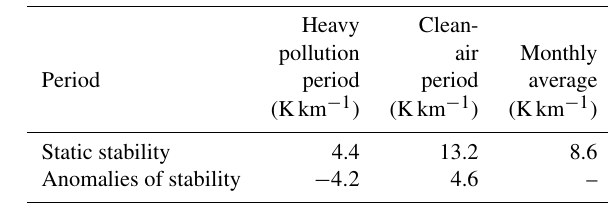
Table 3. Atmospheric static stability below heights of 200m in the boundary layer during heavy pollution and clean-air periods with anomalies relative to the average over January 2016 in